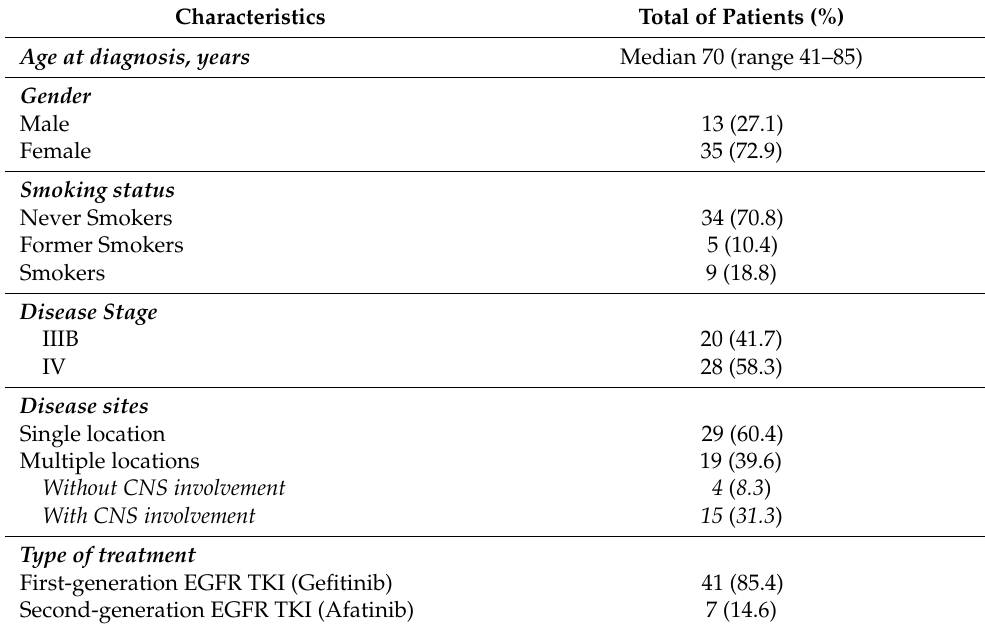
Table 1. Demographic and clinical characteristics of the patients enrolled in the